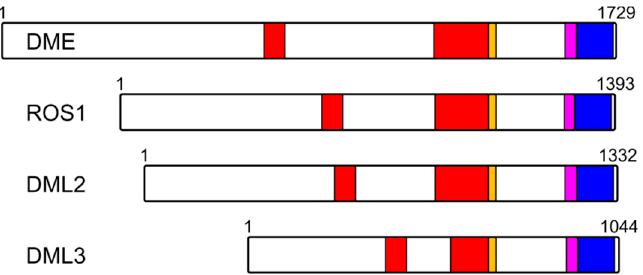
Figure 6. Organization of plant DME-like proteins. Red, split Nth-like domain (HhH superfamily); Orange, FeS cluster; Magenta, permuted CXXC zinc finger; Blue, RRM_DME motif. Numbering corresponds to the A. thaliana species.